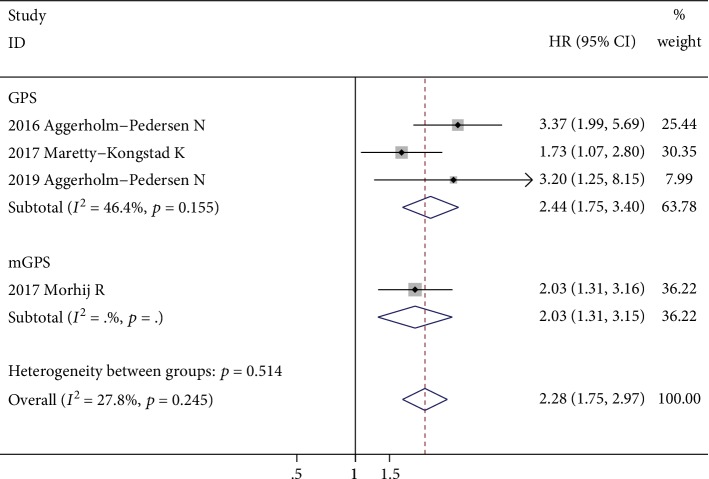
Forest plot showing the association between elevated GPS and DSS in patients with sarcoma. The pooled effect was calculated using a fixed-effects model.